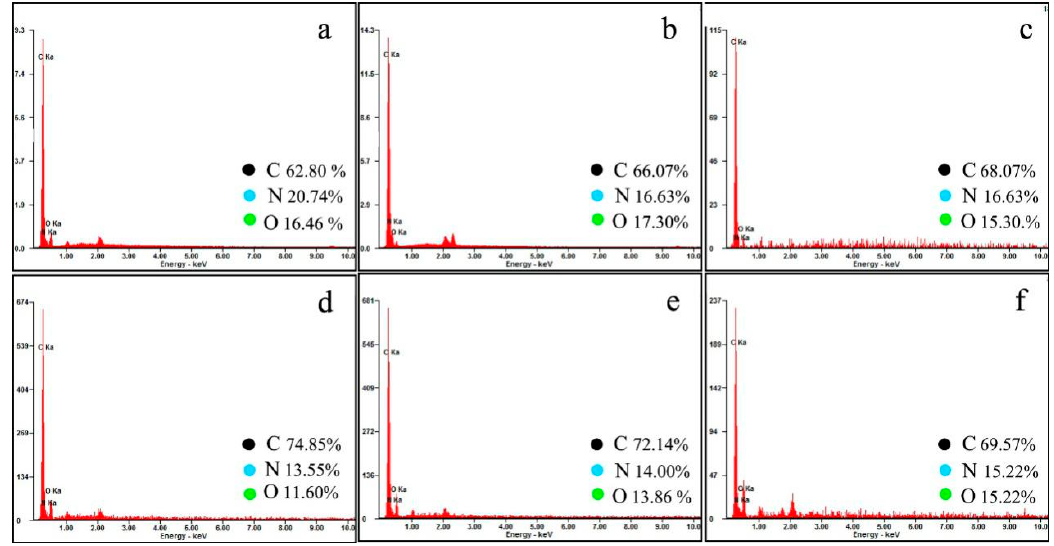
Figure 9. EDS results of microcapsule samples, ( a ) M-0, ( b ) M-3, ( c ) M-4, ( d ) M-5, ( e ) M-6, and ( f ) M- 7.